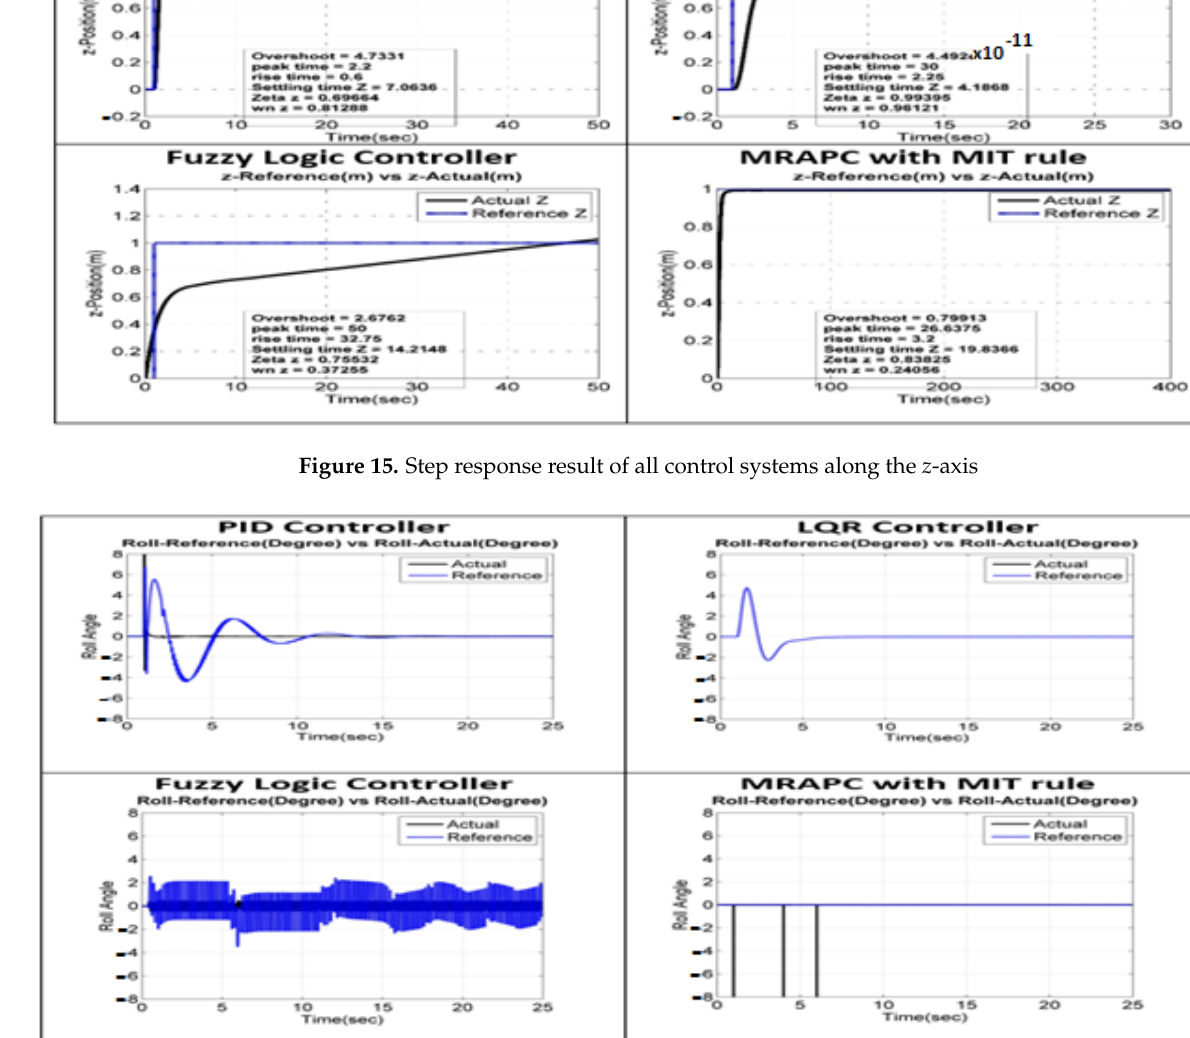
Figure 17. Pitch (θ) Control result depending on ste p input for all control systems In terms of overshoot, rising time, and settling time along the y -axis, the LQR controller performs better. According to Figure 15 and Table 8, the LQR controller achieves superior results along the z -axis than other control approaches because there is no overshoot, the rising time is shorter, and the settling time is shorter. In Figure 16, the LQR controller stabilizes the roll angle in 4 s, which is a much quicker period than the findings of other controllers. The LQR controller, as shown in Figure 17, requires a shorter time to stabilize the pitch angle than other controllers. Figure 18 demonstrates that the system has a negligible yaw angle in the case of the LQR controller structure.